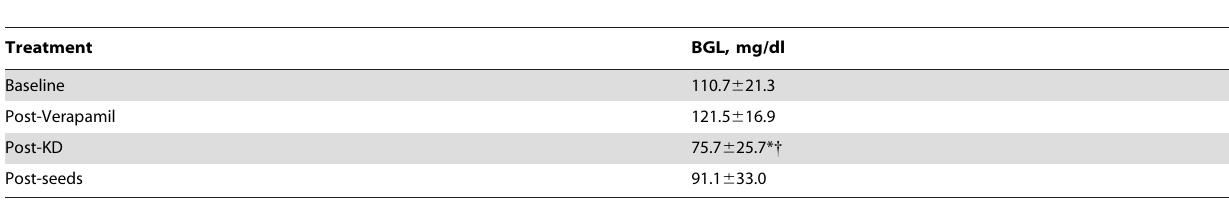
Table 2. Blood glucose level (BGL) before 18 F-FDG administration.